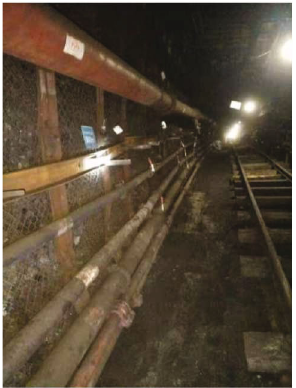
Figure 13: Construction site diagram of roadway after